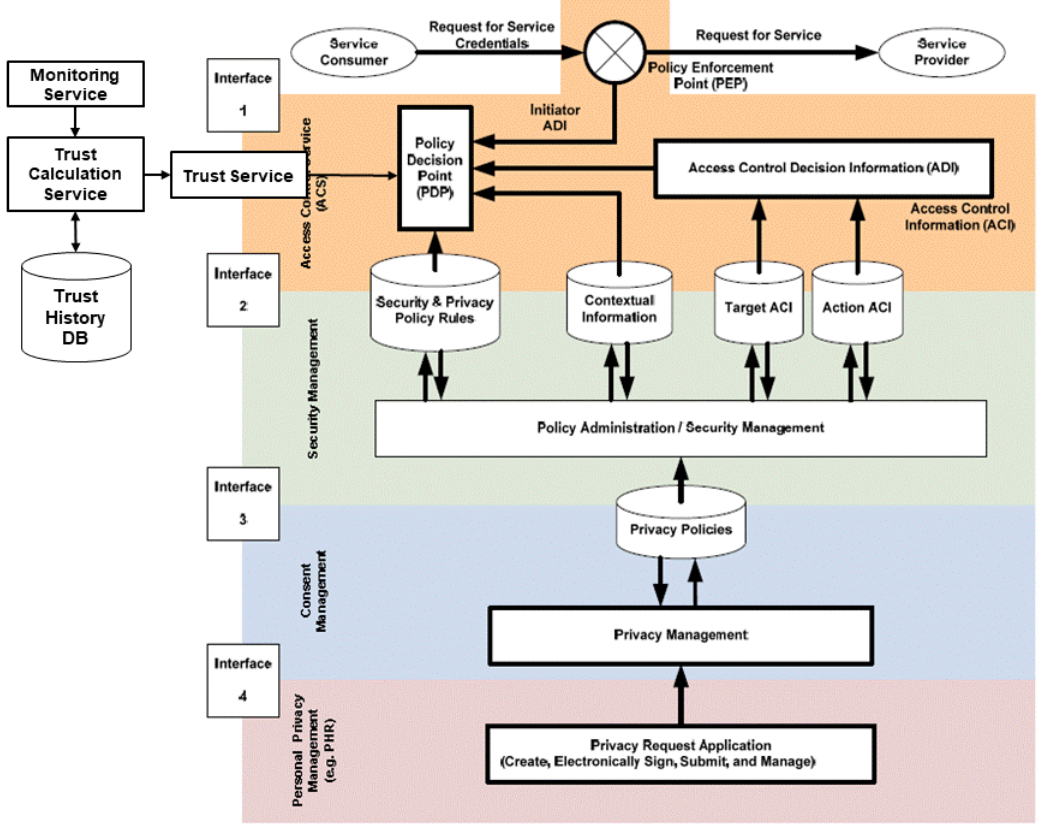
Figure 2. Adapted HL7/OMG Authorization Reference Model (after [4]).